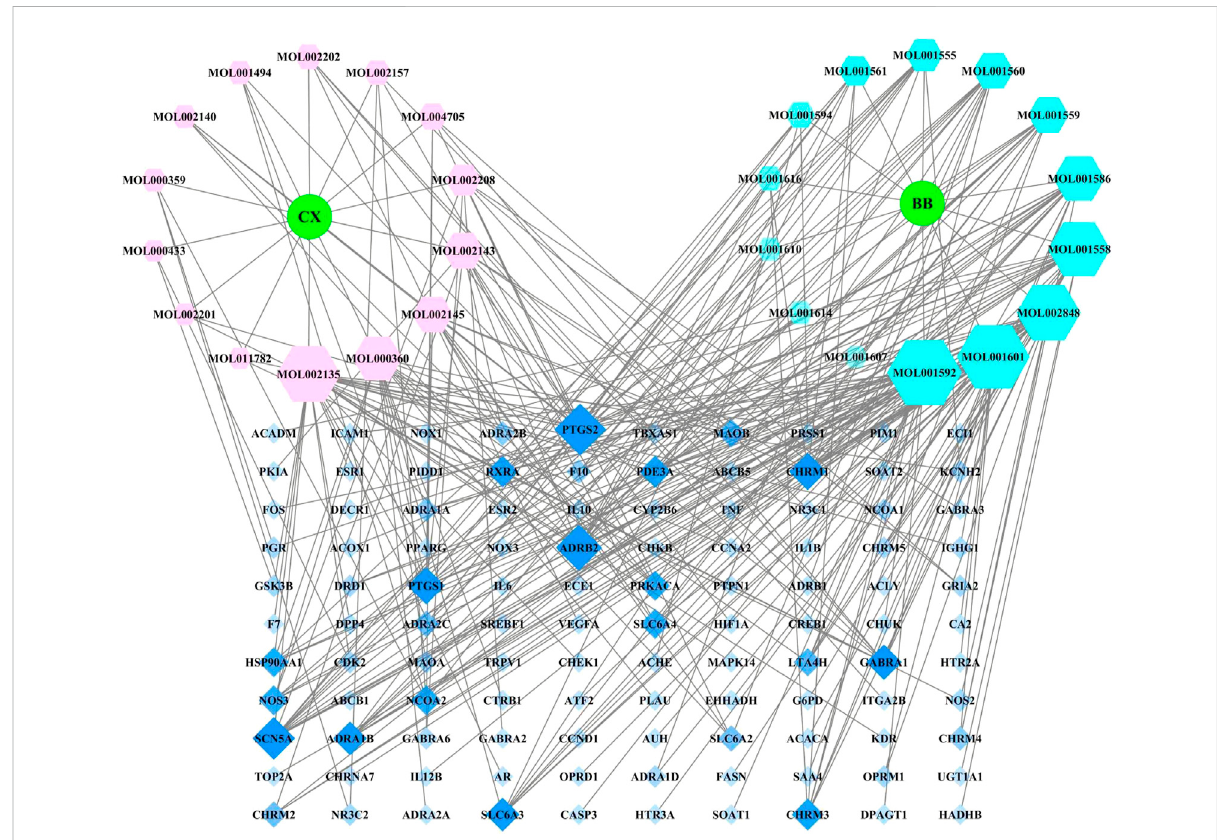
FIGURE 3 Network diagram of active ingredients of Ligusticum chuanxiong-Piper longum couplet medicines and migraine targets.